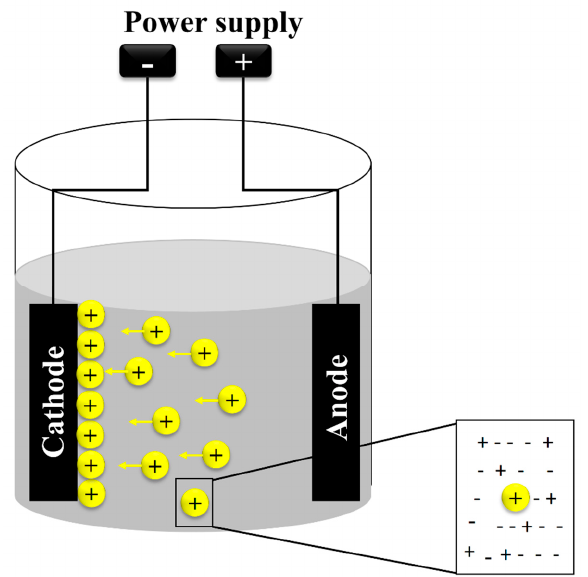
Figure 5. A schematic illustration of the conventional set-up for electrophoretic deposition (EPD) of HAp coatings. Table 2. The advantages and limitations of the techniques used for fabrication of HAp biocoatings